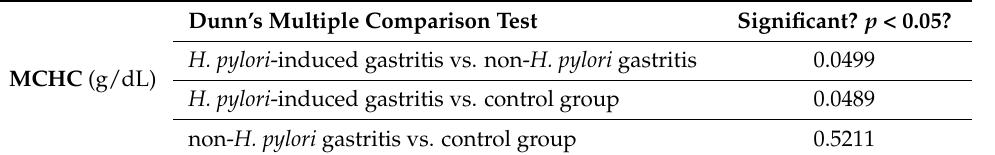
Table 5. The difference of median values of neutrophils between the three groups.